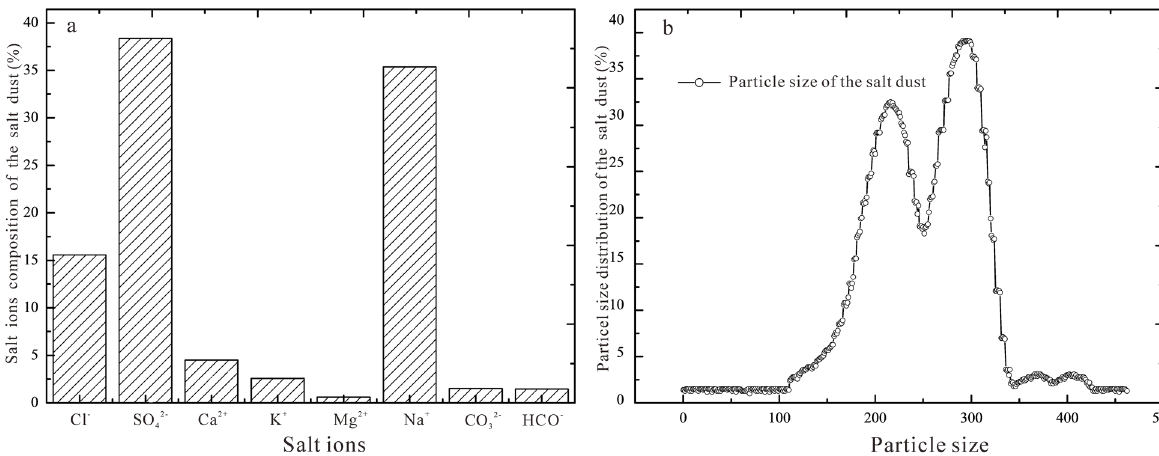
Fig 3. Salt ion fractions in (a) and particle size distributions (b) of the salt dust ( μ m).